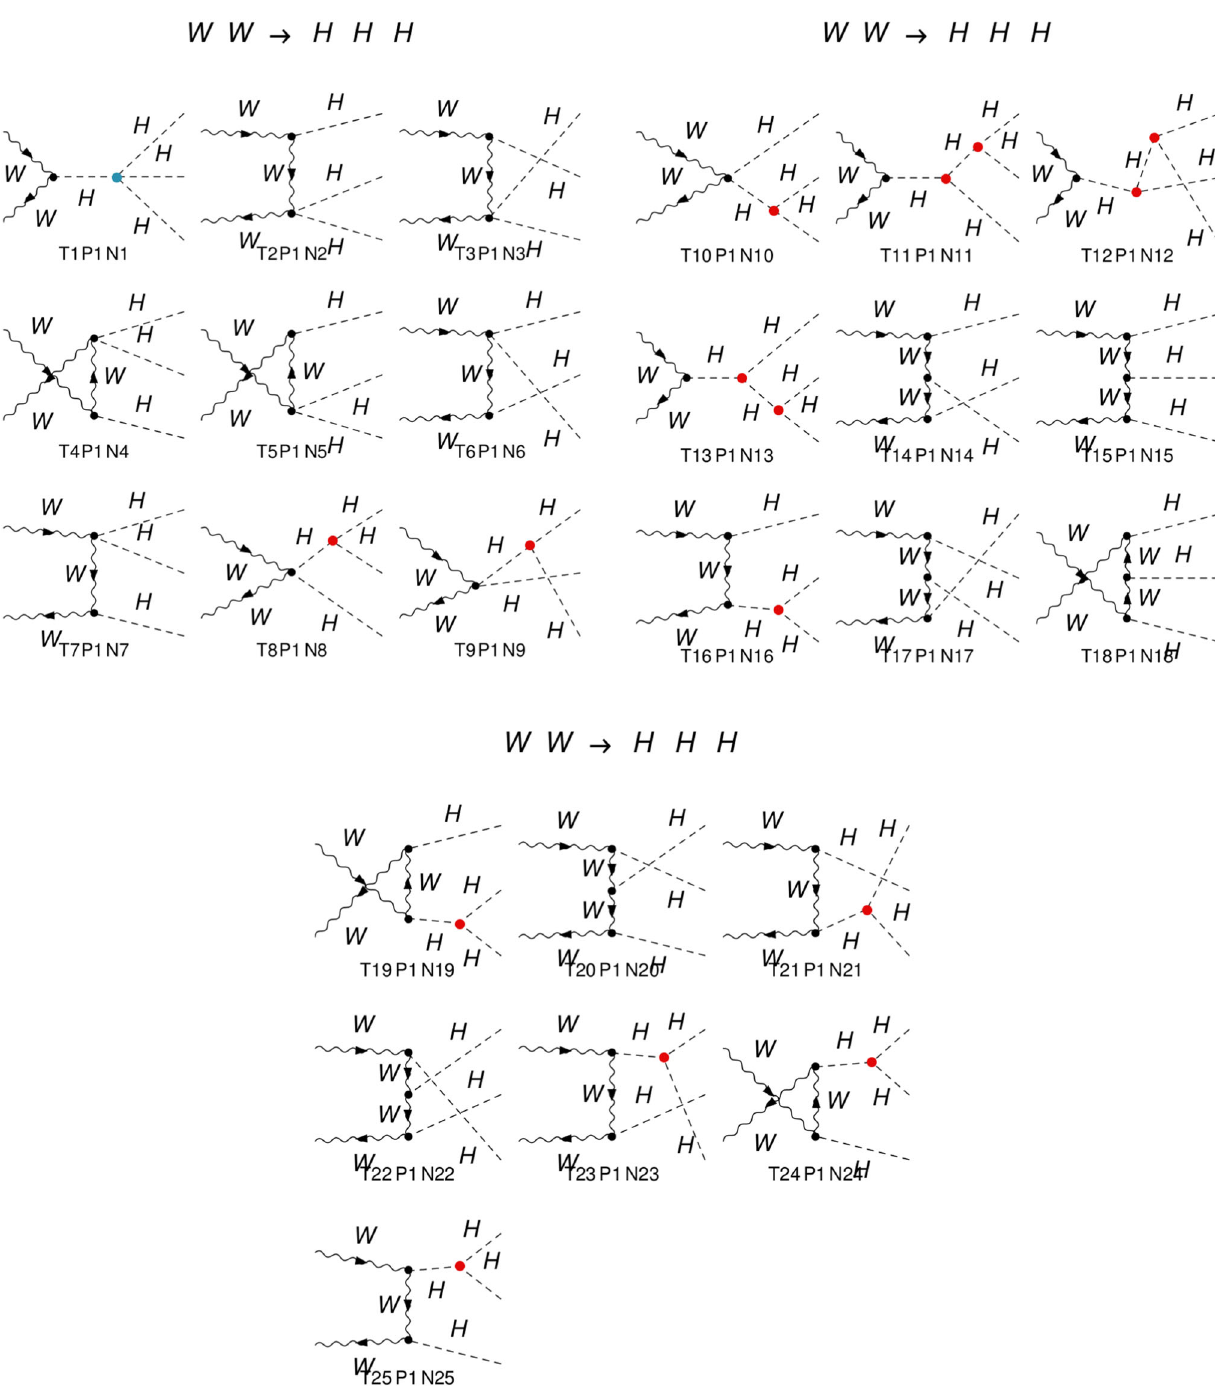
Fig. 39 Diagrams contributing to the W − W + → H H H subprocess in the unitary